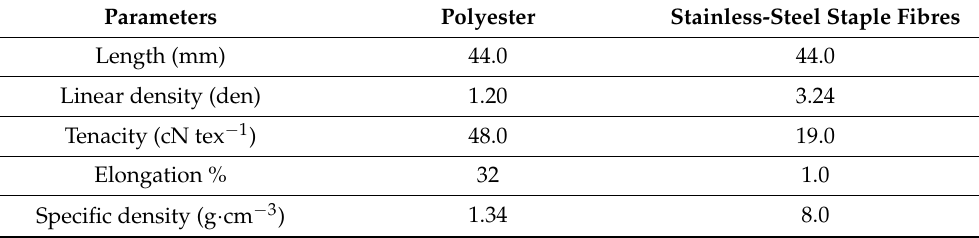
Table 1. Physical characteristics of fibres.